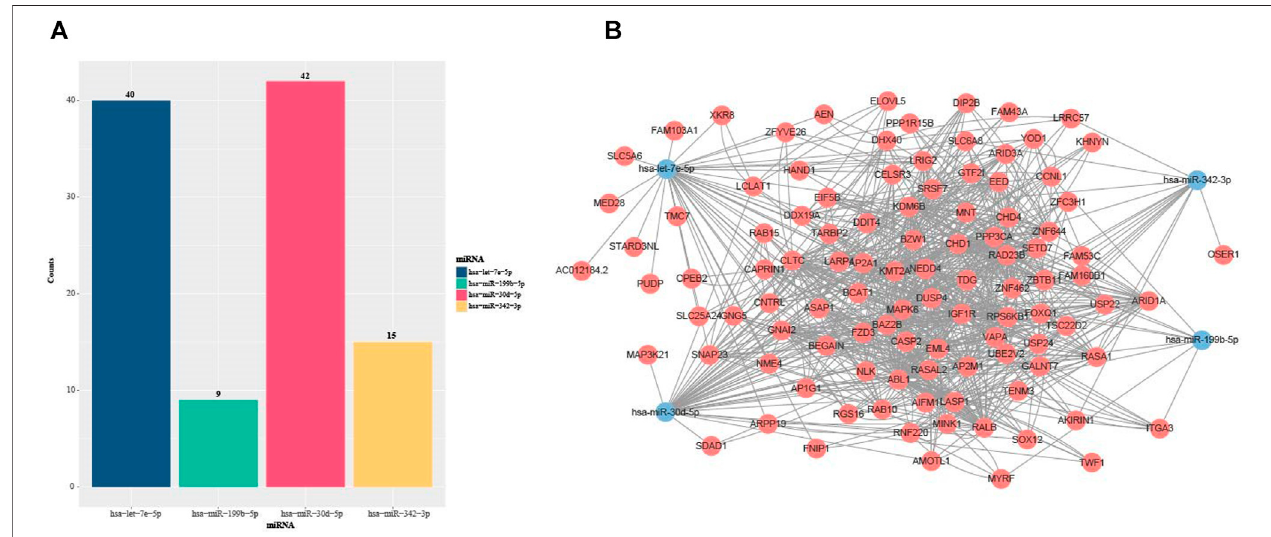
FIGURE 3 | Statistics of miRNA target miRNAs in DMEDSig-4. (A) Bar chart of DEMDSig-4 target genes (B) miRNA-mRNA interaction network diagram of DEMDSig-4. Red: target mRNAs; Blue: miRNAs of